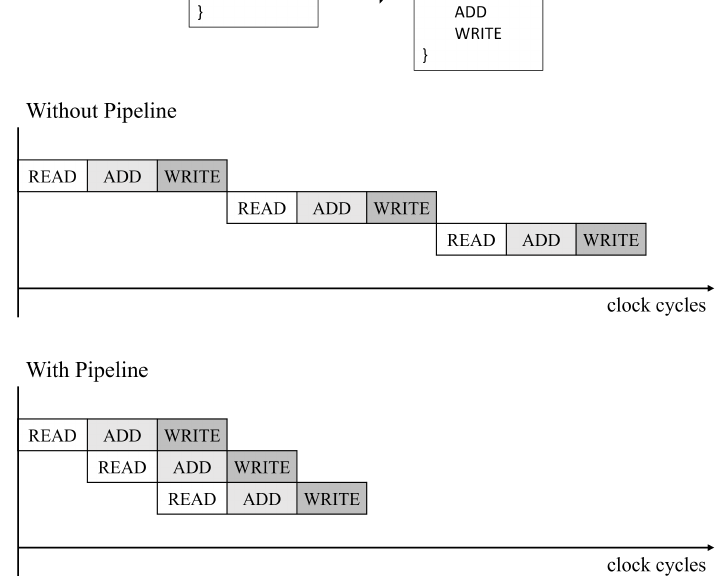
Figure 8. Pipelined operations.